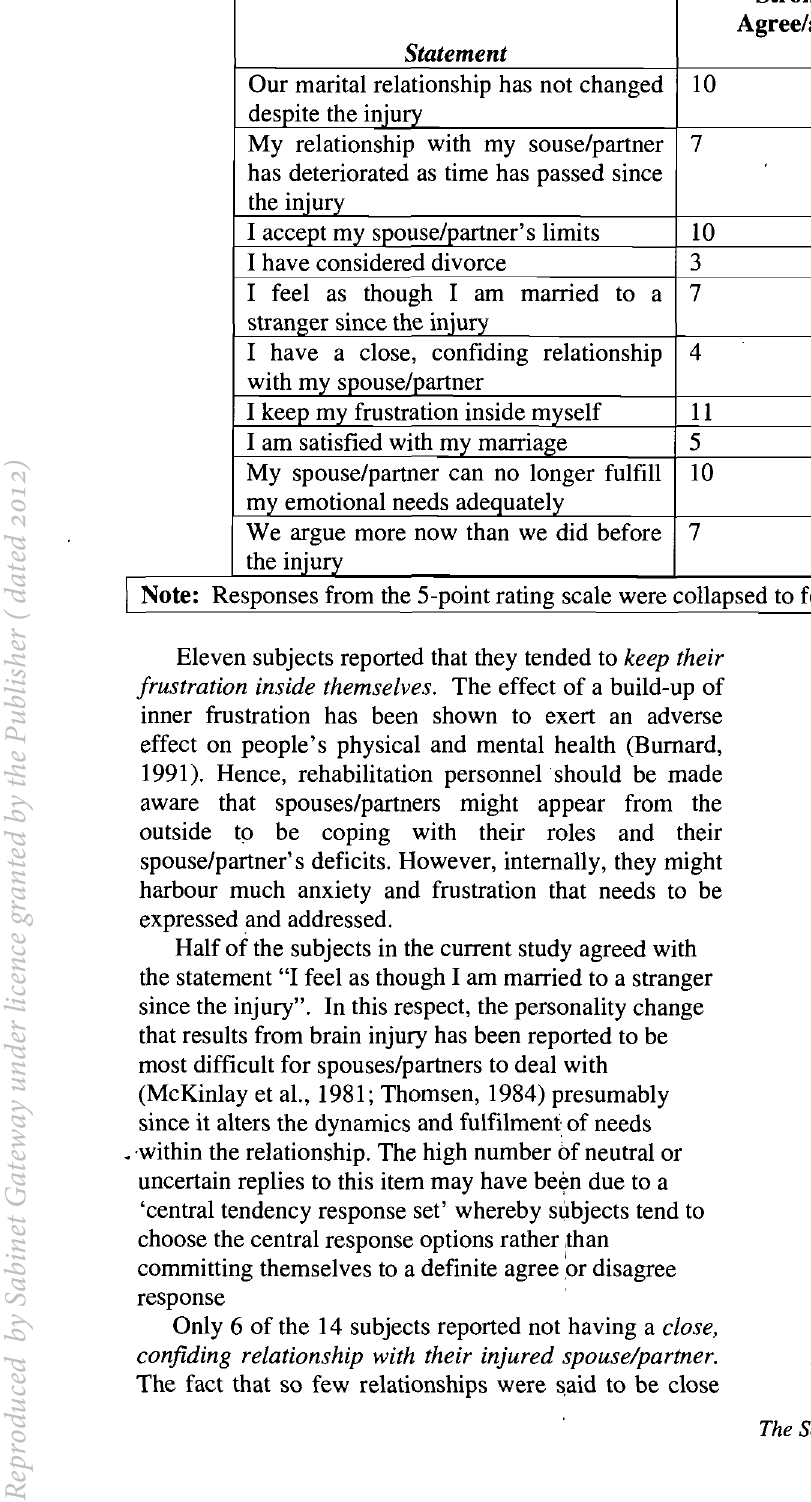
Table 4: Perceived influence of injury on marital/common law relationship